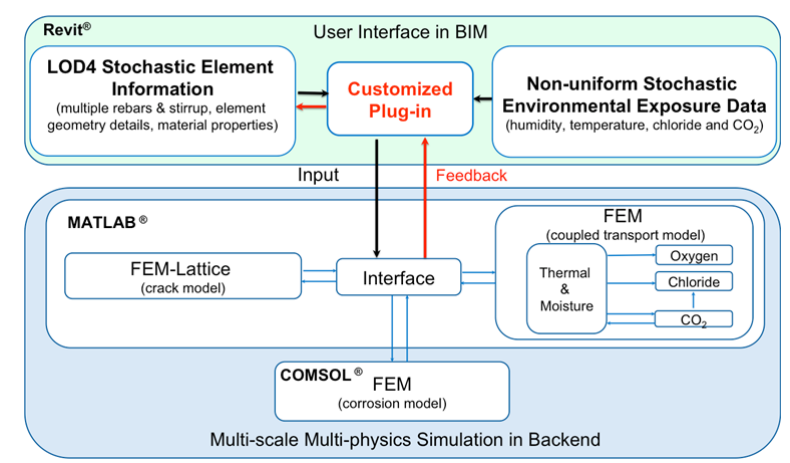
Figure 7. Architecture of the multi ‐ physics and multi ‐ scale model to predict and assess the deterioration of reinforced concrete structures in an interactive framework using a customized plug ‐ in to connect the deterioration model to a user ‐ friendly building information modelling (BIM) interface [40].